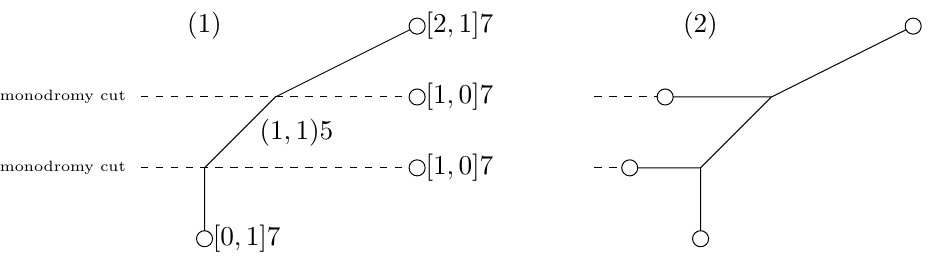
Figure 24 . The brane web (1) shows two D5 branes stretched between two different D7 branes and ending on the same NS5 brane. This configuration does not violate the s -rule [29] and is supersymmetric. (2) If we attempt to decompose the brane web into two subwebs, black and blue, the resulting configuration is not supersymmetric. This is because there are two D5 branes stretched between the same D7 and NS5 brane which violates the s -rule.